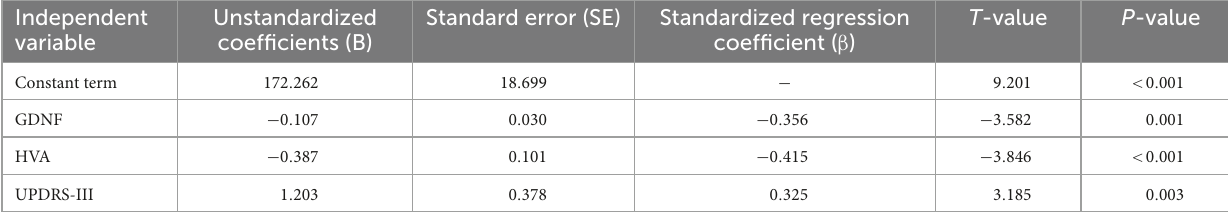
TABLE 4 Stepwise linear regression analysis result of TMT-A as the dependent variable. Independent